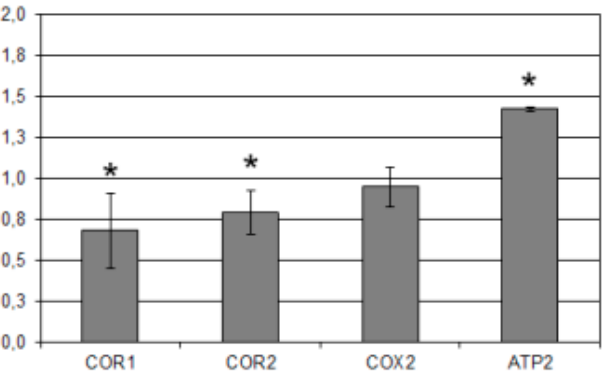
Figure 4. Western Blot analysis of mitochondrial extracts from yeast cells grown in presence of 50 µ Mm Htcum. Quantification of immunoreactive luminescence signals was achieved by densitometric scanning of the respective bands. Signals were normalized to the 0.5% DMSO treated cultures (control); POR was used as a loading control. Quantification was performed on three independent blots and reported as mean of values ( ± S.D.). * p ≤ 0.05 vs. control.